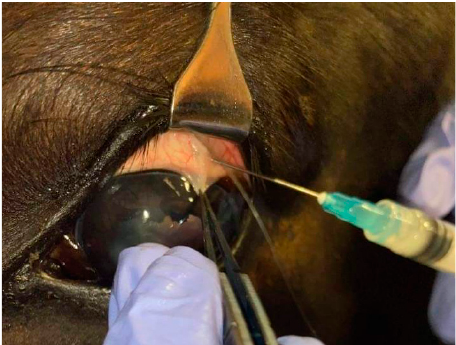
Figure 7. Performing a subconjunctival injection in the dorsolateral quadrant with placement of TPU/PLDLA implant containing CsA.